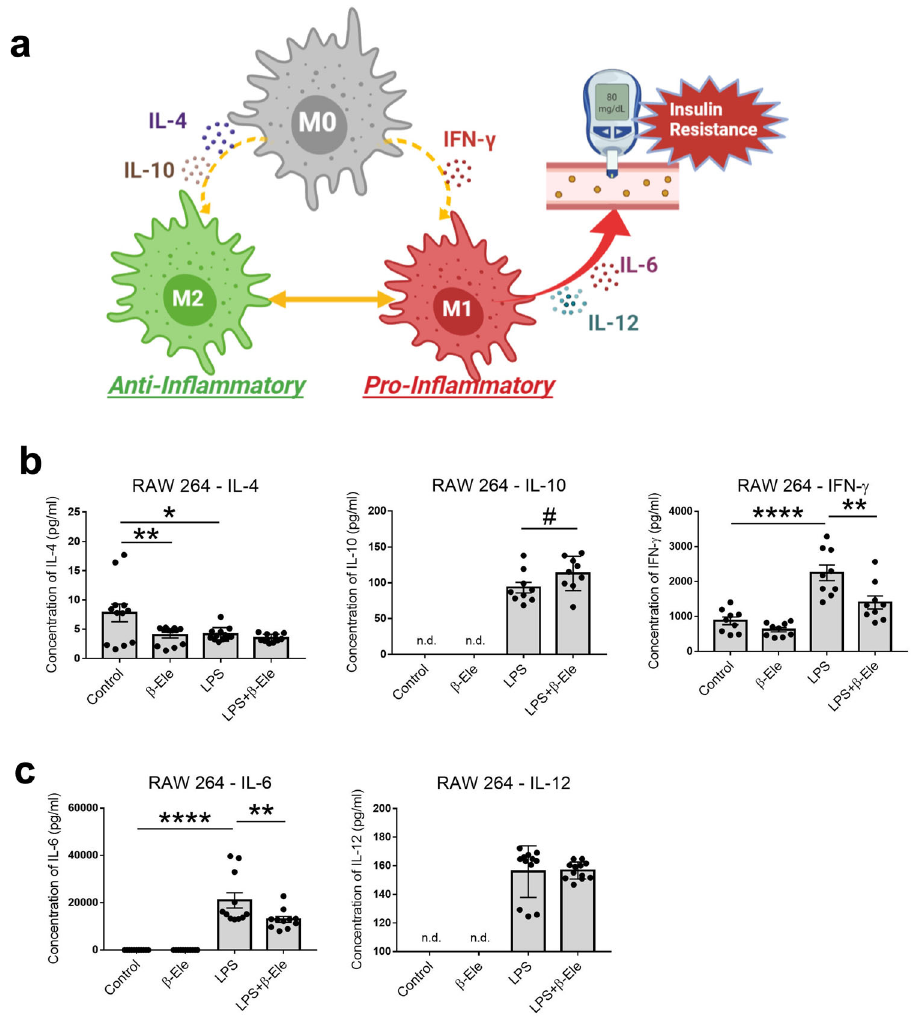
Fig. 7 Effects of β -elemene on regulating the protein levels of in fl ammation-related cytokines in RAW 264 cells. a The mechanism of macrophages polarization. b , c Effects of β -elemene (0 and 10 μ g/ml) on LPS (0 and 10 μ g/ml)-induced changes in the protein levels of IL-4 ( n = 12), IL-10 ( n = 9), and IFN- γ ( n = 9) ( b ), IL-6 ( n = 11) and IL-12 ( n = 12) ( c ) in RAW 264 cells. The results are shown as the mean ± SEM. # p < 0.1, * p < 0.05, ** p < 0.01, **** p < 0.0001 versus 0 μ g/ml LPS or 0 μ g/ml β -elemene assessed using one-way ANOVA followed by Tukey ’ s multiple comparisons or two-tailed Student ’ s t -test. n.d. indicates that the data were below the detection limit. The results present data from three independent